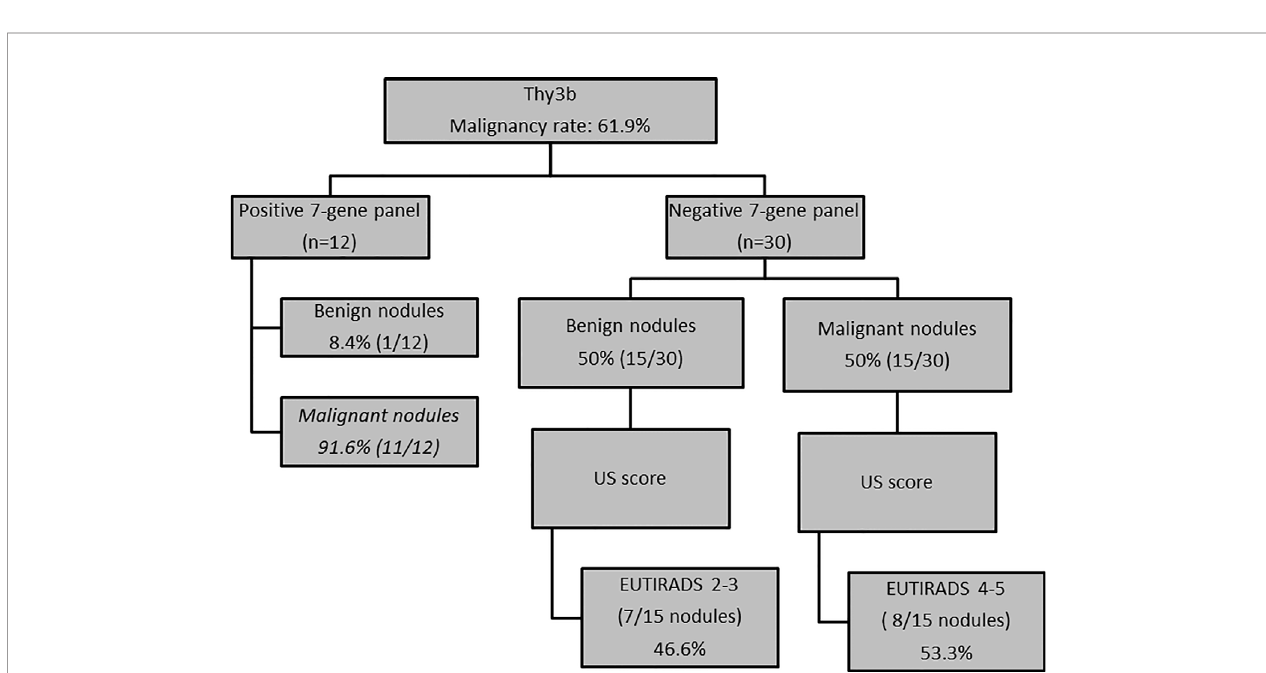
FIGURE 3 | US and molecular features as criteria for decision-making in TIR3B nodules (n = 42 nodules).